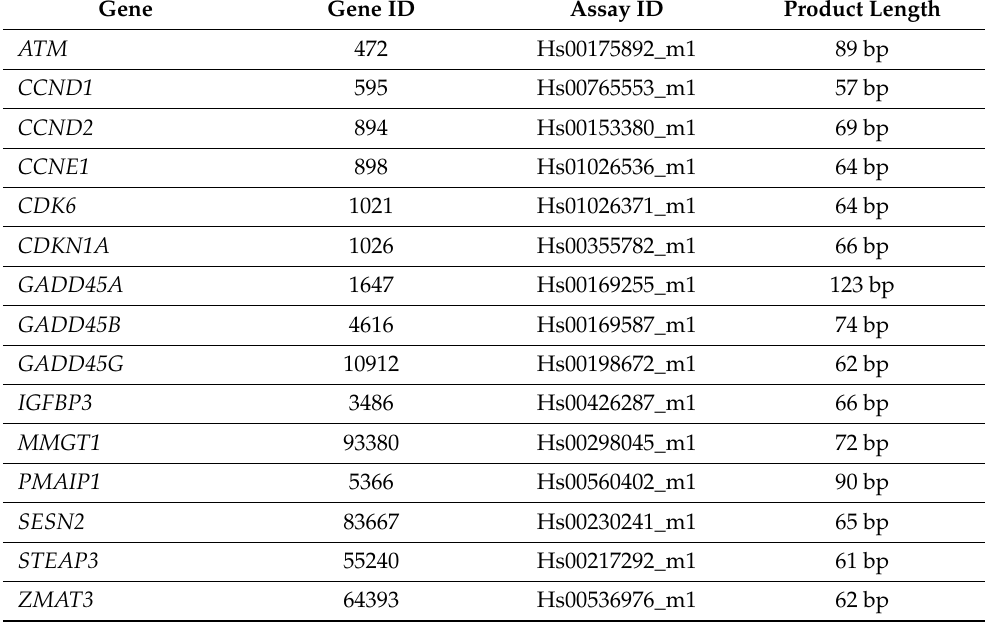
Table 1. TaqMan primer.